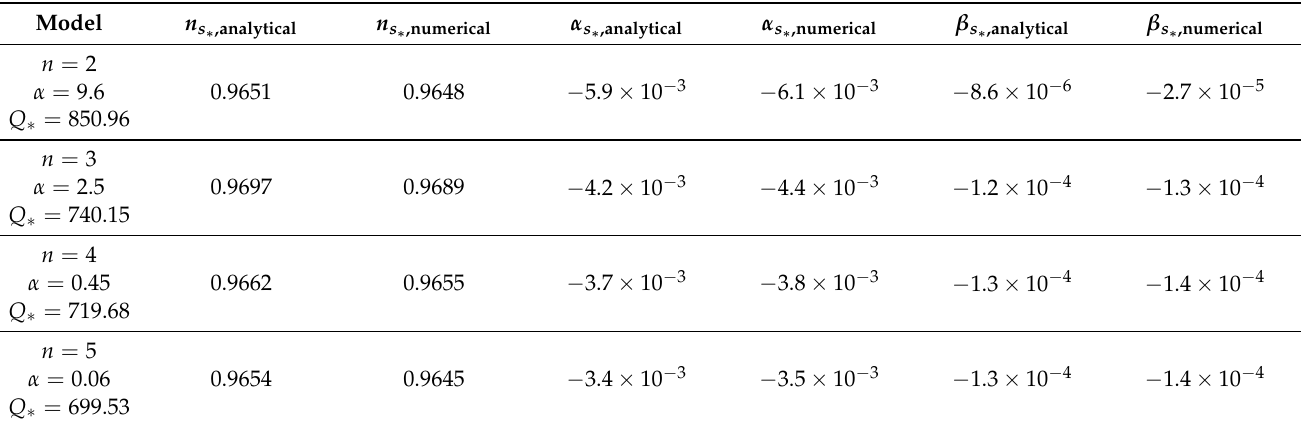
Table 4. Analytical estimation of n s , α s and β s , along with their full numerical determination, for 4 sets of chosen